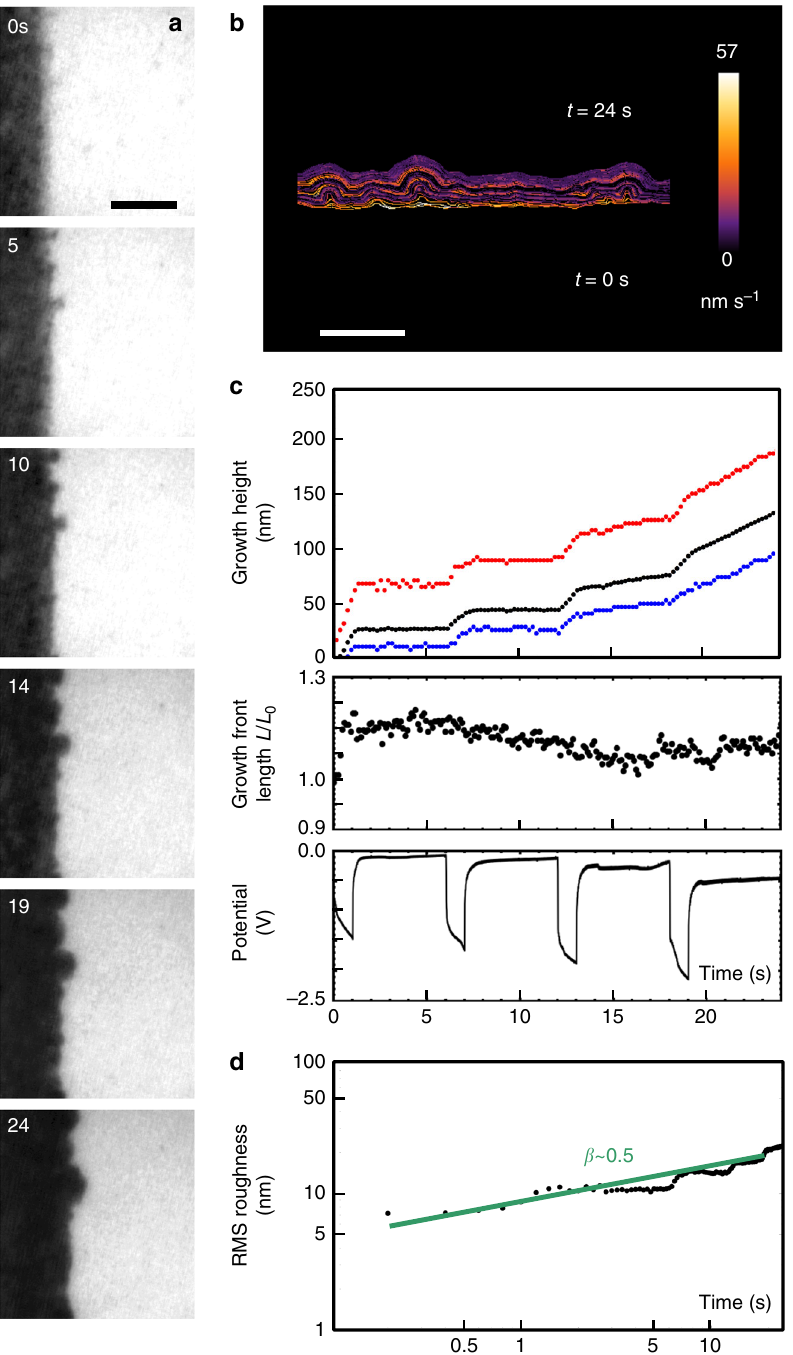
Fig. 4 Electrochemical deposition of Cu under pulse-plating conditions. a Images recorded in bright- fi eld conditions extracted from Supplementary Movie M5. Deposition took place in cycles consisting of total current 400 nA for 1 s and then zero for 5 s. The electrolyte was the same as in Fig. 1. Times are shown in seconds since current fl ow began. Scale bar 300 nm. b Interface position from movie frames, color coded by normal growth speed. Scale bar 200 nm. c Structural and electrical data as a function of time: growth height (black = average; red = maximum; and blue = minimum), relative length of growth front, and potential. The average growth rate, including off time, is 13 nm s − 1 . This is equivalent to 340 A m − 2 time-averaged current density, or 2040 A m − 2 in the pulses. d RMS roughness of the growth interface shown as a log – log plot. The best- fi tting straight line and exponent are